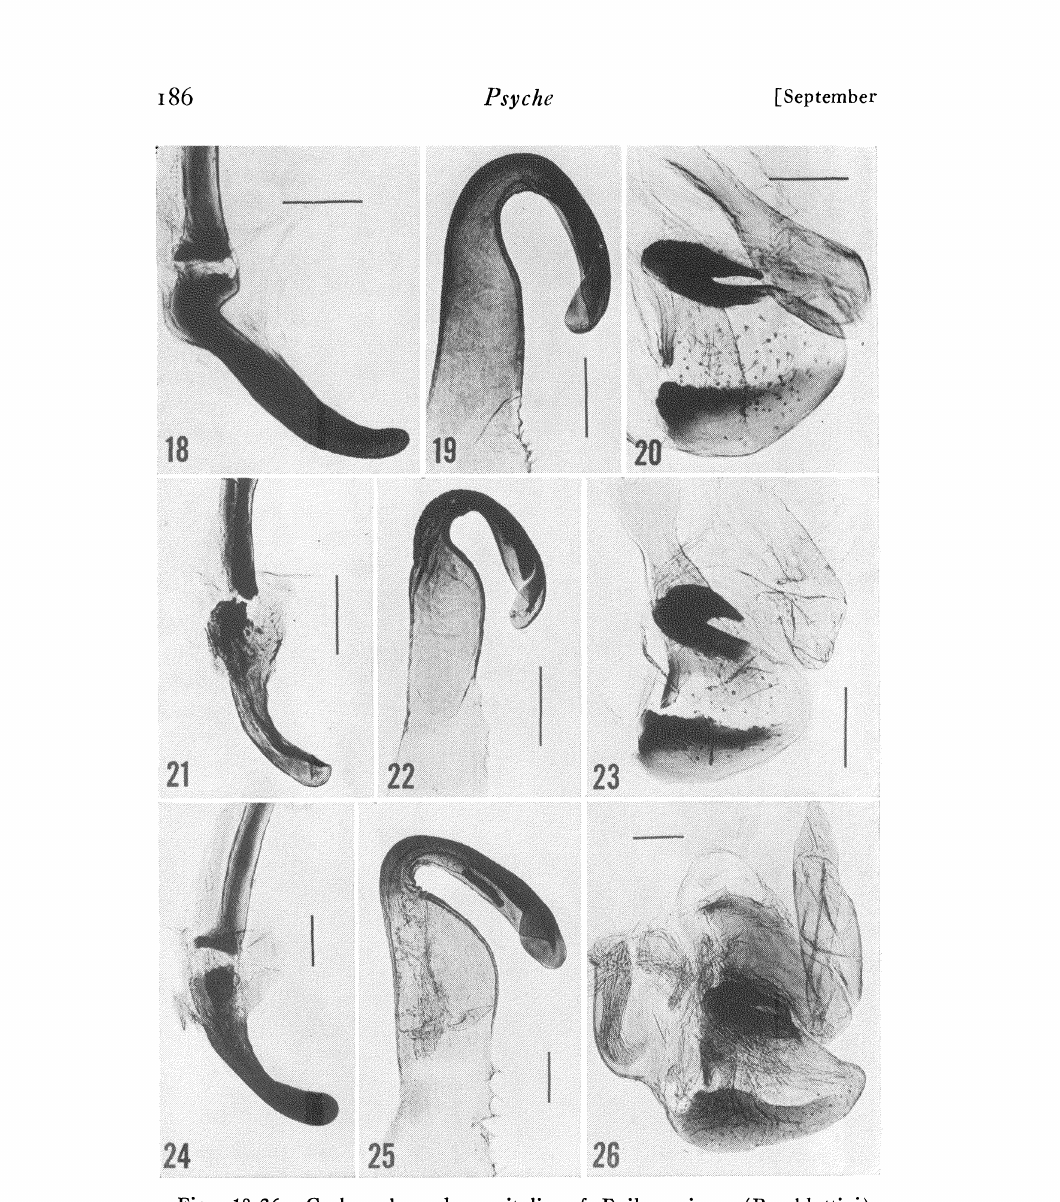
Figs. 18-26. Cockroach male genitalia o Epilamprinae (Poroblattini). 18-20. (ANSP). Galiblatta cribrosa Hebard. Type No. 1029. St. Jean du Maroni, French Guiana. 21-23. (USNM). Galiblatta illiamsi. Taruma- Acu, about 15 Km. northeast of Manaus, Amazonas, Brazil (det. Roth). 24-26. (17 MCZ). Dryadoblatta scotti. (from specimen shown in "Fig. 3). (Figs. 18-23 from Roth, 1968). (scale 0.3